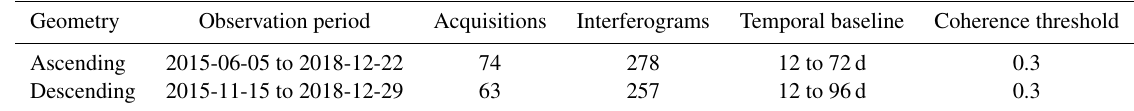
Table 1. Summary of ISBAS processing parameters.